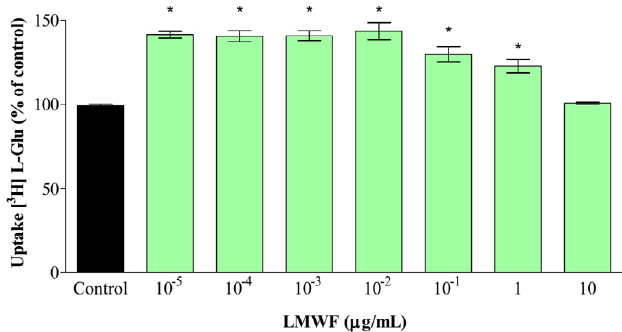
Figure 4. Assessment of [3H]-L-GLU uptake induced by LMWF into synaptosomes. Effects of increasing concentrations of LMWF (10 -5 to 10 μg/μL) on [3H]-L-Glu uptake. Data presented as mean ± SEM of three experiments performed in triplicate. Statistical significance was determined by the Newman Keuls post-test. * p <0.001 compared to the